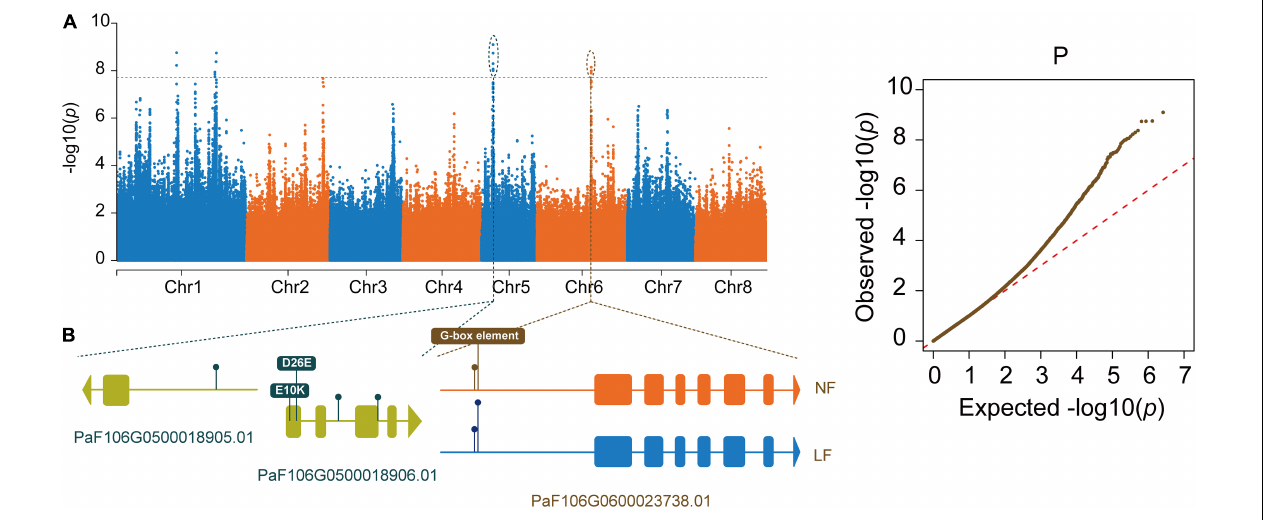
FIGURE 2 | GWAS of flowering time in Prunus sibirica . (A) Manhattan and quantile–quantile (QQ) plots for GWAS. (B) Gene structures of candidate genes. Brown box indicated G-box element in the promoter of PsTPPF . Rounded rectangle and triangle represented exons and the last exons, respectively.